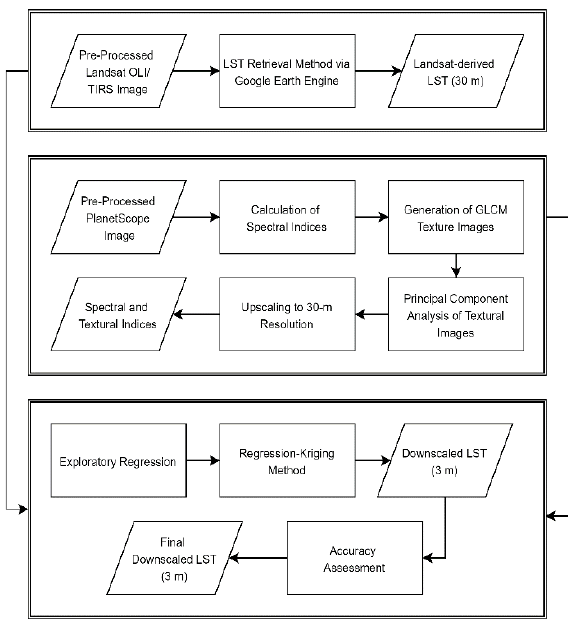
Figure 3. General workflow of the